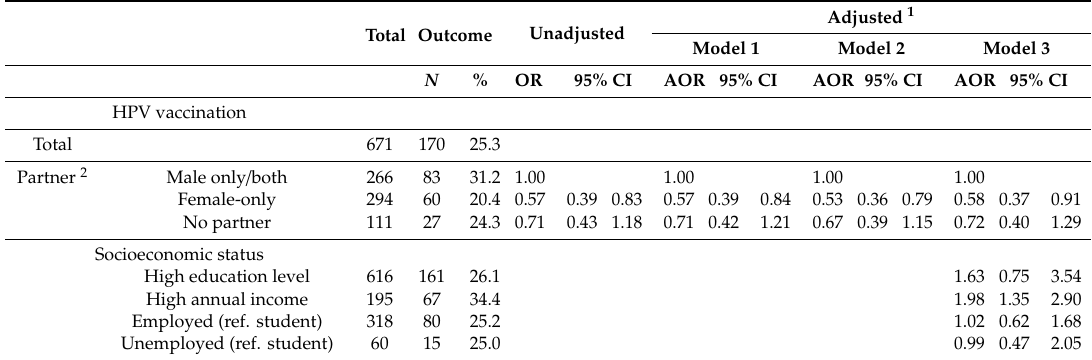
Table 3. Multivariable logistic regression analysis of human papillomavirus (HPV) vaccination by sex of sexual partners and socioeconomic